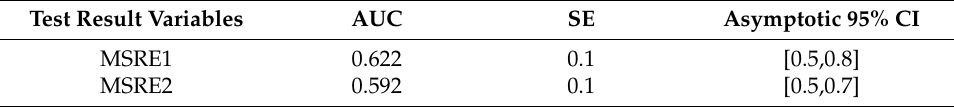
Table 3. The area under the curve (AUC) threshold of the